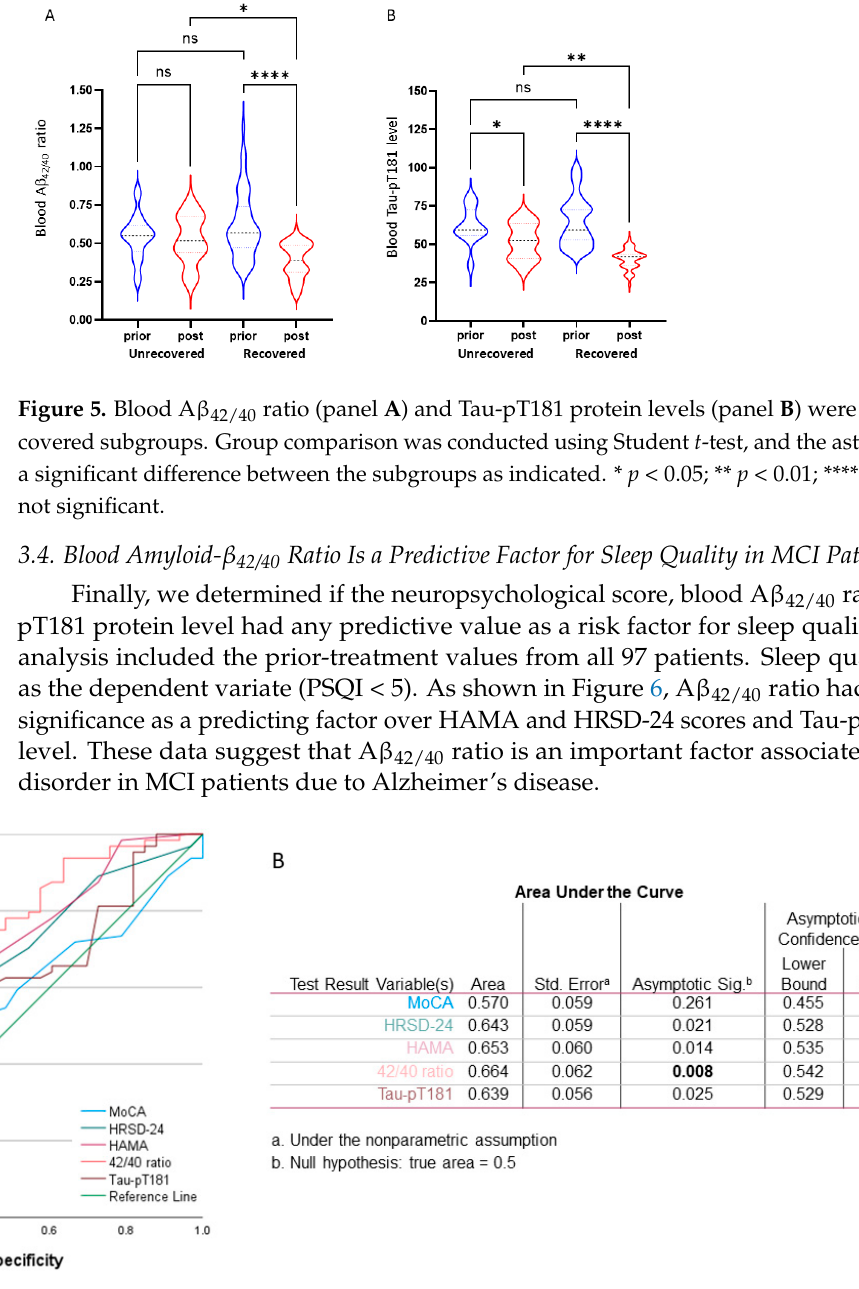
Figure 4. Different improvements in recovered (panel A ) and unrecovered (panel B ) subgroups. The neuropsychological scores, blood A β 42/40 ratio, and Tau-pT181 protein level were presented as case-controlled pairs of prior- and post-treat- ment values. The p values were derived from a pair-wise t-test.